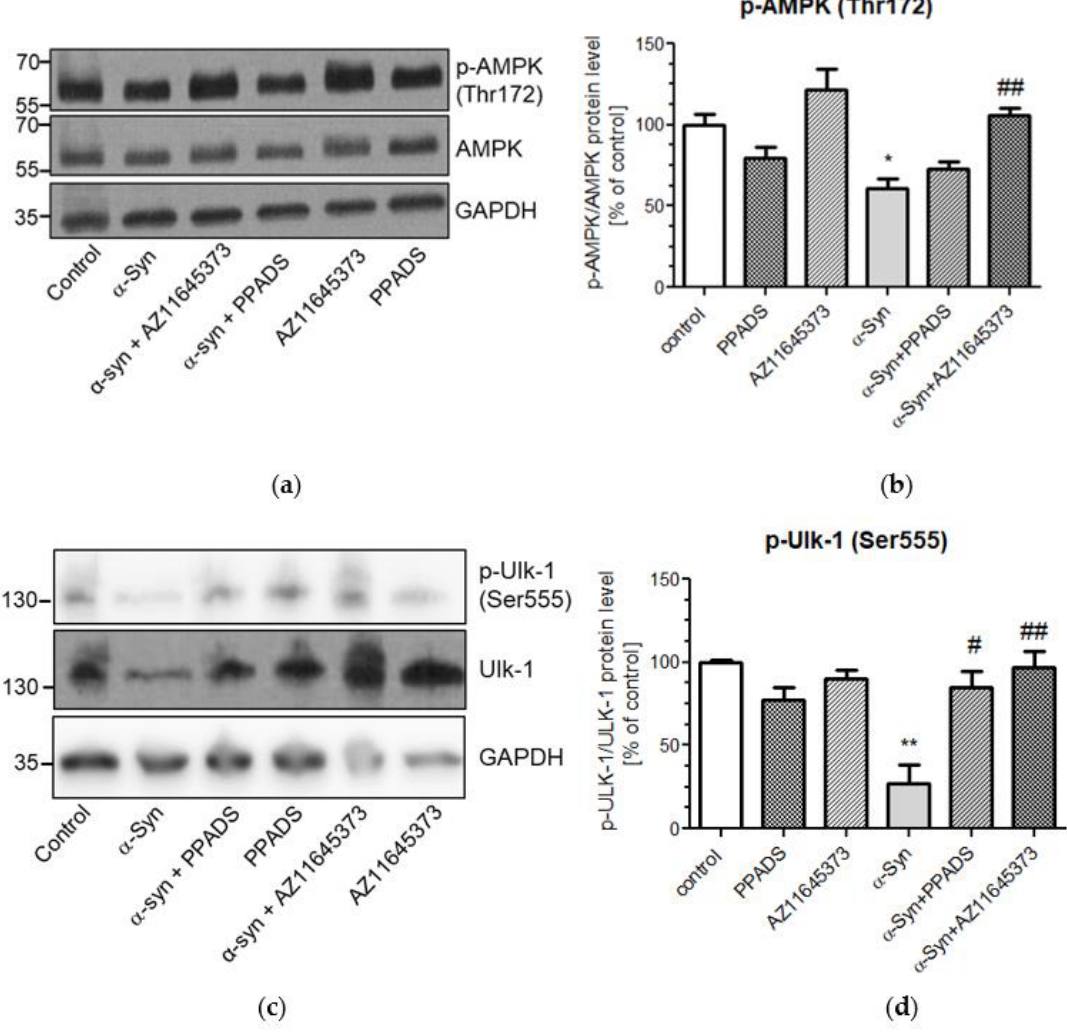
Figure 5. P2X7R activation induced by α -Syn treatment decreases AMPK phosphorylation in SH-SY5Y cells. ( a ) SH-SY5Y cells were treated with 10 µ M α -Syn for 24 h in the presence of 100 µ M PPADS or 10 µ M AZ 11645373. Protein levels of phosphorylated AMPK (Thr172) and AMPK were then analysed by Western blotting. GAPDH was used as the loading control. ( b ) Phospho-AMPK immunoreactivity normalized to AMPK in SH-SY5Ycells. Data were normalized to the untreated control group ( = 100%) and represent the mean value ± S.E.M. for five independent experiments. * p < 0.05 compared to control, ## p < 0.01 compared to α -Syn, using one-way ANOVA followed by Bonferroni post hoc test. ( c ) SH-SY5Y cells were treated with 10 µ M α -Syn for 24 h in the presence of 100 µ M PPADS or 10 µ M AZ 11645373. Protein levels of phosphorylated Ulk-1 (Ser555) and Ulk-1 were then analysed by Western blotting. GAPDH was used as the loading control. ( d ) Phospho-Ulk-1 immunoreactivity normalized to Ulk-1 in SH-SY5Y cells. Data were normalized to the untreated control group ( = 100%) and represent the mean value ± S.E.M. for four independent experiments. ** p < 0.01 compared to control, # p < 0.05; ## p < 0.01 compared to α -Syn, using one-way ANOVA followed by Bonferroni post hoc test.